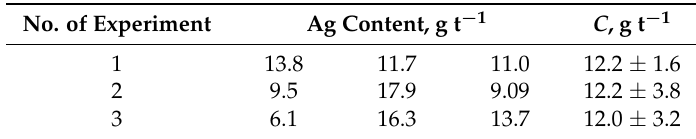
Table 2. Results of SV determination of silver in the pyrite of the Kirovsko–Kryklynskaya ore zone ( n = 5, P = 0.95).